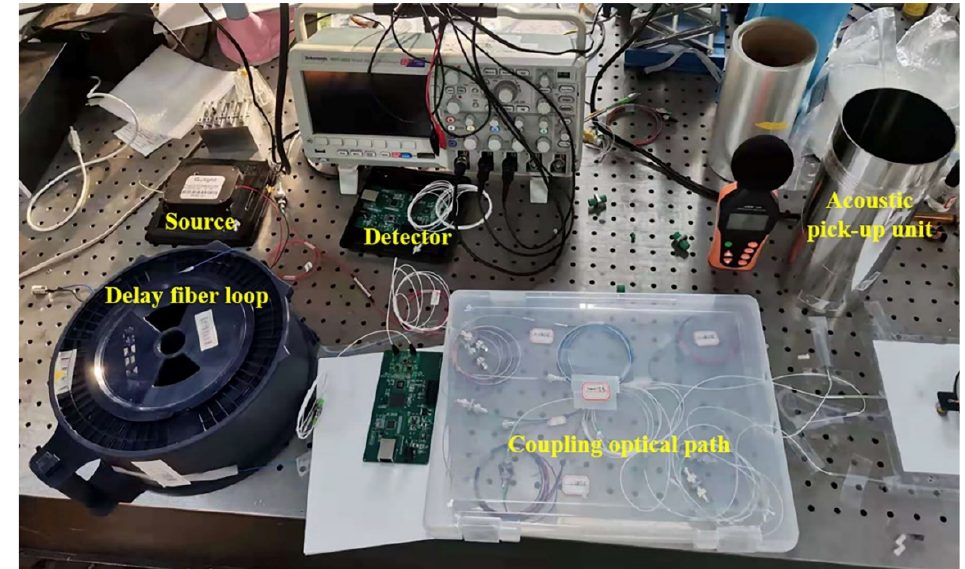
Figure 6. A photo of the testing system.